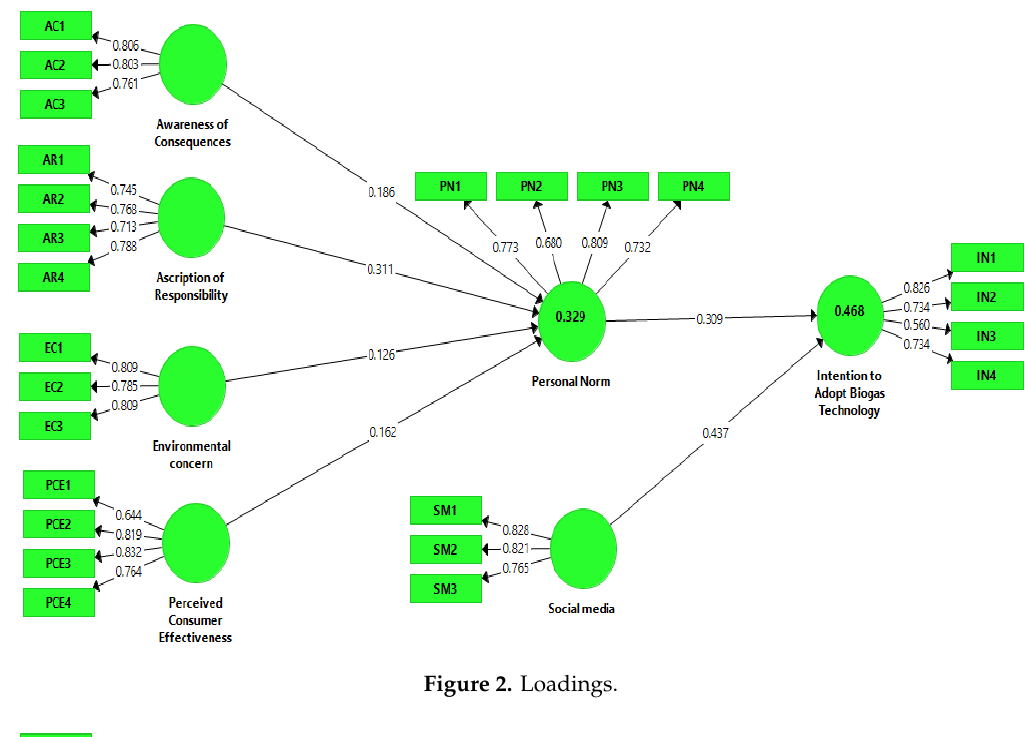
Figure 2. Loadings.